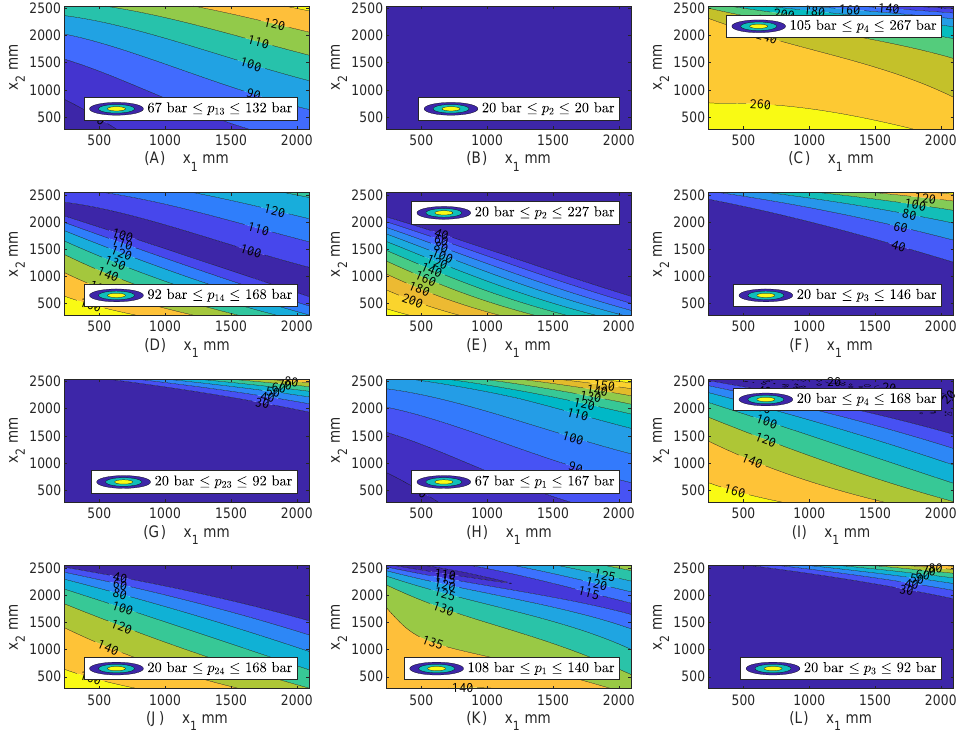
Figure A2. Design pressures over the course of piston strokes for shared chamber topologies. ( A – C ) p 13 , p 2 , p 4 for the case with chambers 1 and 3 shared; ( D – F ) p 14 , p 2 , p 3 for the case with chambers 1 and 4 shared; ( G – I ) p 23 , p 1 , p 4 for the case with chambers 2 and 3 shared; ( J – L ) p 24 , p 1 , p 3 for the case with chambers 2 and 4